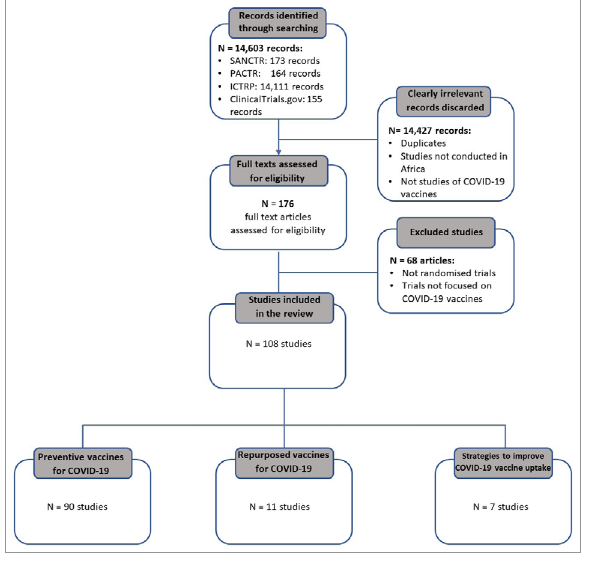
Figure 1: Flow chart showing study search and selection processes. A total of 50% ( n =54) of the trials had not yet started enrolment, 47% ( n =51) were ongoing, 2% ( n =2) had completed enrolment, and the status of 1% ( n =1) was indicated as withdrawn. Phase 1 trials comprise 16% ( n =17), 15% ( n =16) are phase 2 trials, 8% ( n =9) are phase 2/3